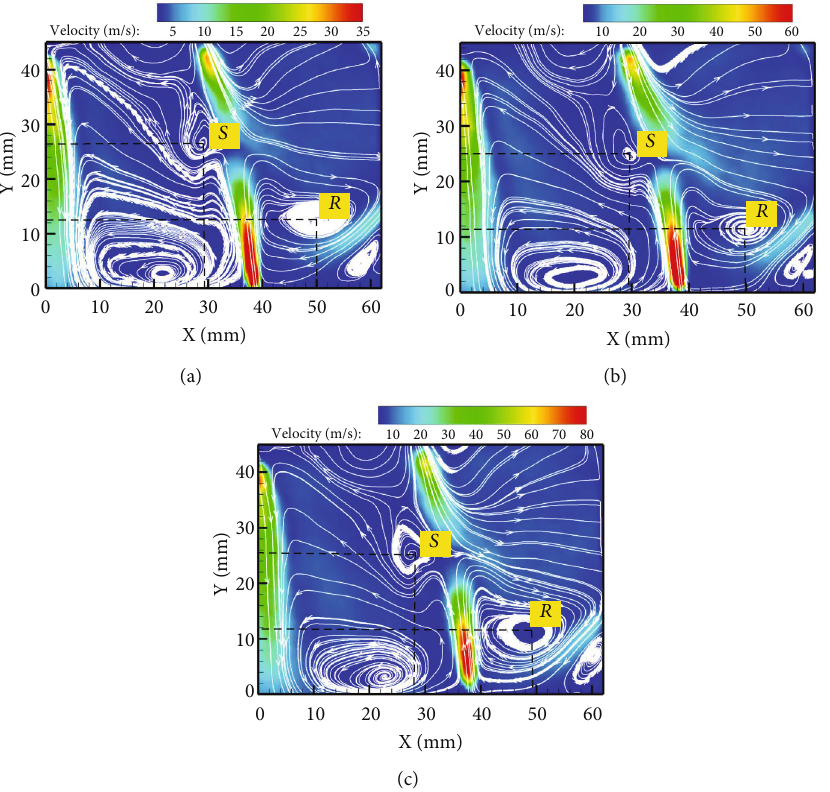
ζ ζ B =1%, (b) B =3%, and (c) B =5%.